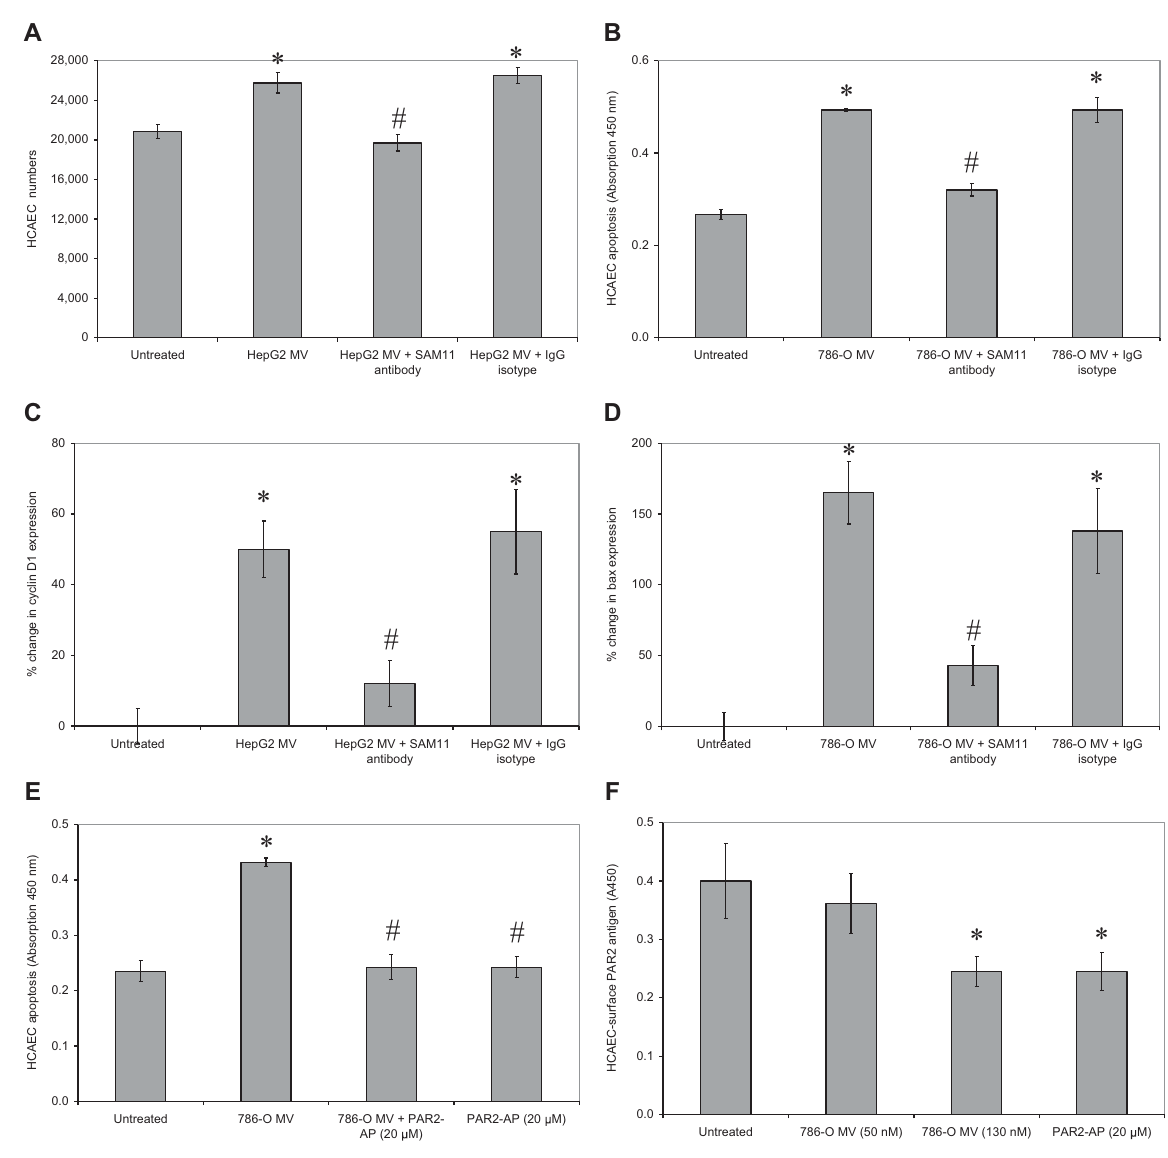
Fig. 4 Examination of the involvement of PAR2 in microvesicle-induced HCAEC apoptosis. Sets of HCAEC (2 (cid:1) 10 4 ) were preincubated with a blocking anti-PAR2 antibody (SAM11; 20 µ/mL) or a control isotype. Sets of cells were then incubated with microvesicles derived from ( A ) HepG2 cell line (50 nM) for 24 hours and cell numbers were determined by crystal violet staining assay ( n ¼ 5; (cid:4) ¼ p < 0.05 vs. the untreated sample, # ¼ p < 0.05 vs. the sample devoid of antibody). ( B ) A similar set of cells was incubated for 24 hours with microvesicles derived from 786-O cell line (50 nM) and the rate of apoptosis determined using the TiterTACS chromogenic TUNEL assay ( n ¼ 5; (cid:4) ¼ p < 0.05 vs. the untreated sample, # ¼ p < 0.05 vs. the sample devoid of antibody). Total RNA was extracted from samples of the treated HCAEC and ( C ) the relative expression of cyclin D1 mRNA, and ( D ) bax mRNA was analyzed by RT-PCR against β -actin as housekeeping ( n ¼ 3; (cid:4) ¼ p < 0.05 vs. the untreated sample, # ¼ p < 0.05 vs. the sample devoid of antibody). ( E ) HCAECs (2 (cid:1) 10 4 ) were incubated for 24 hours with microvesicles derived from 786-O cell line (50 nM) in the presence or absence of PAR2-activating peptide (20 µM) and the rate of apoptosis determined ( n ¼ 5; (cid:4) ¼ p < 0.05 vs. the untreated sample, # ¼ p < 0.05 vs. microvesicles only). ( F ) HCAECs (2 (cid:1) 10 4 ) were incubated for 30 minutes with microvesicles derived from 786-Ocell line (0 – 130nM), orPAR2-activtingpeptide (20µM). The cellswerethenincubatedwitha mouseantihumanPAR2antibody (SAM11; 20 µg/mL) and probed with a HRP-conjugated goat antimouse antibody diluted 1:1000 (v/v). The relative amount of cell-surface PAR2 was then measured using the TMB substrate ( n ¼ 5; (cid:4) ¼ p < 0.05 vs. the untreated sample). HCAEC, human coronary artery endothelial cells; PAR2, protease-activated receptor-2; RT-PCR, reverse transcription polymerase chain